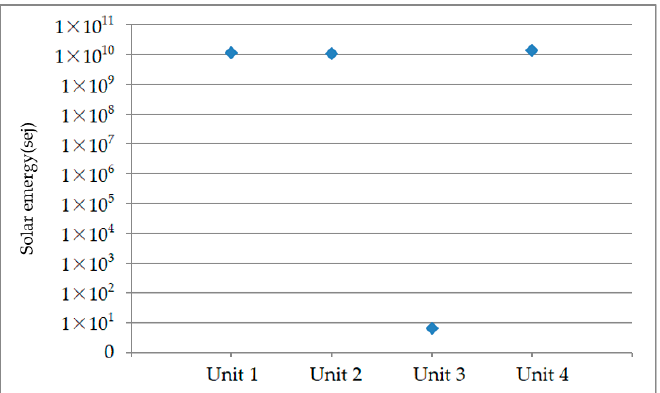
Figure 7. The ECPCE index of four generating units .